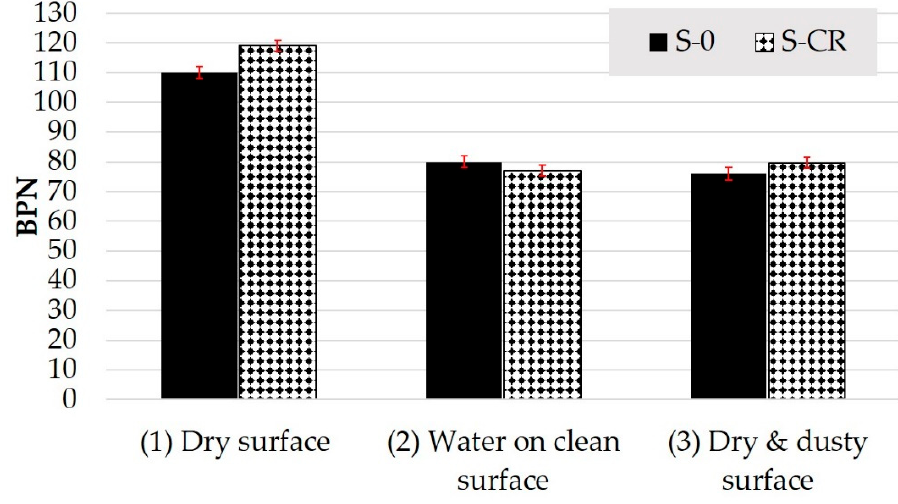
Figure 13. BPN levels during phases (1), (2), and (3) for the S-0 and S-CR specimens.